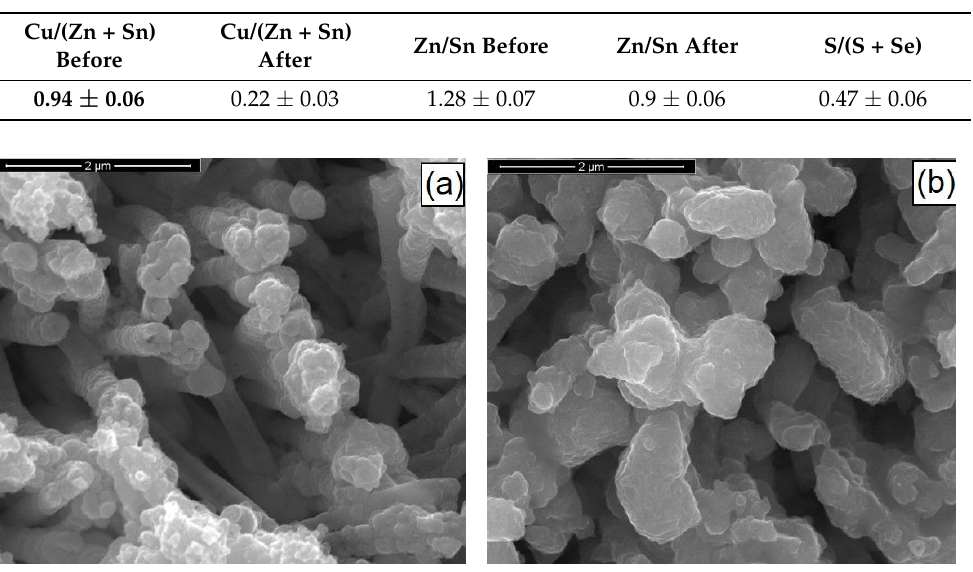
Figure 8. SEM images of CZTSe nanostructures ( a ) before and ( b ) after annealing. NWs were obtained at pH = 3 with a copper content of 1 mM.